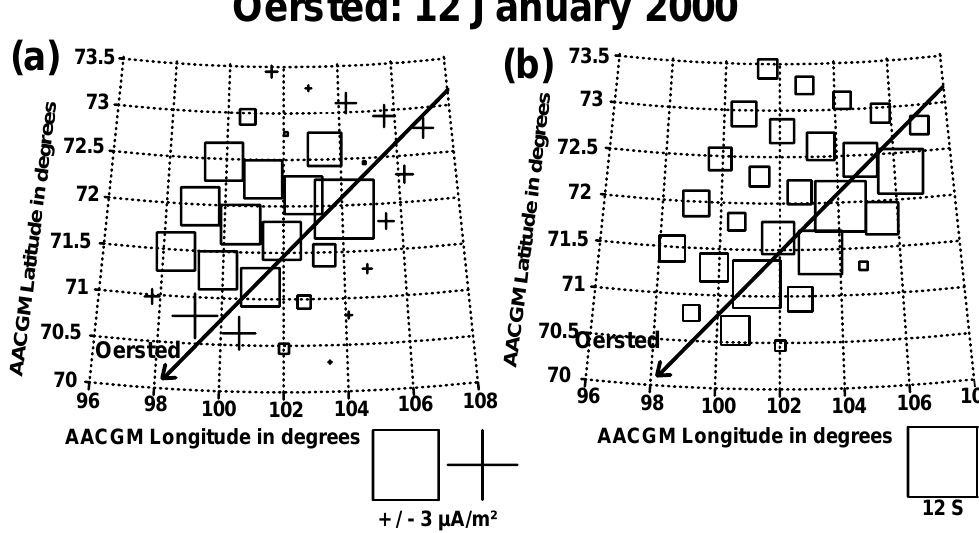
Fig. 10. Two-dimensional distributions in AACGM coordinates (a) of the field-aligned current deduced from the Ørsted measurements and (b) of the modelled Pedersen conductance, assuming a Hall-to-Pedersen conductance ratio equal to 1. The parameters are plotted in the form of symbols, of which the size is proportional to the intensity of the parameter. Squares and crosses represent, respectively, the upward currents and downward currents. The projection of the Ørsted orbit is also